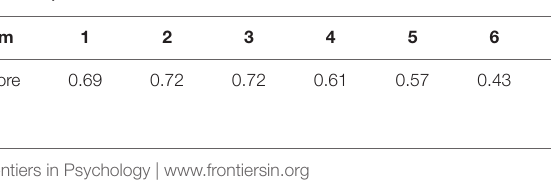
TABLE 1 | Correlation coefficient between each item score and total score.